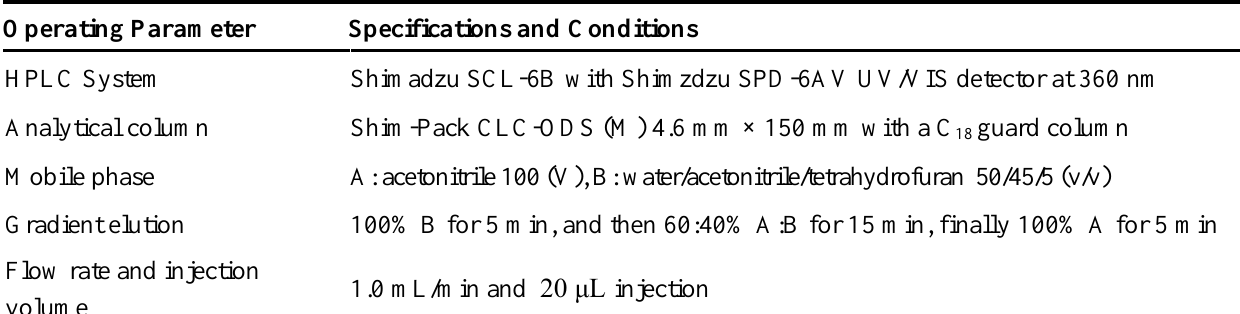
Table 2. Operating conditions of HPLC for carbonyl compounds